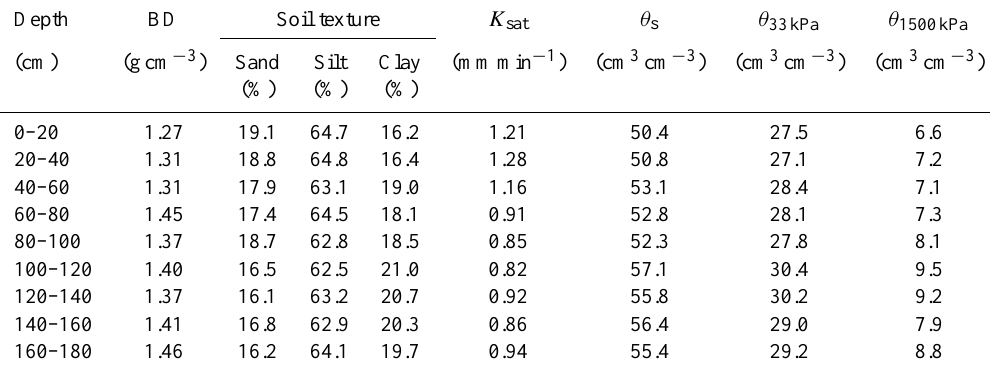
Table 1. Soil properties of 0–180cm at the study site.